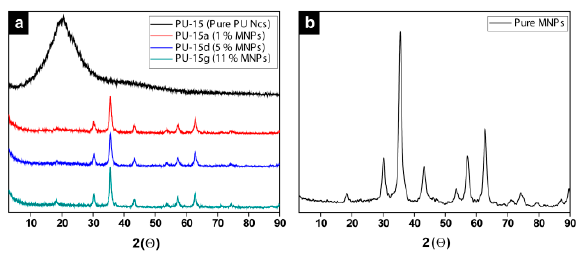
Figure 13. XRD pattern of ( a ) PU NCs (PU-15) and MNPs-IL-C 4 @PU NCs and ( b ) pure MNPs.